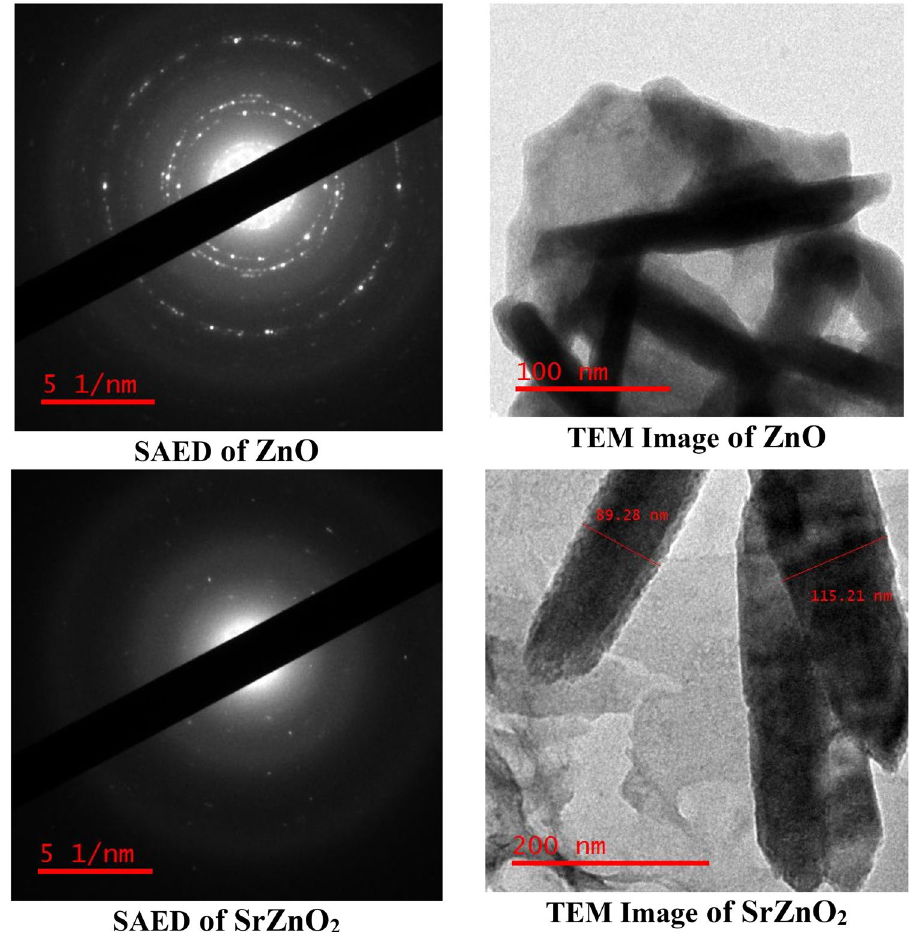
Fig. 4 SAED and TEM images of ZnO and SrZnO